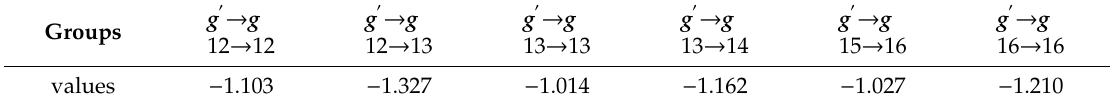
(cid:48) → g s , l = 1, k = 6